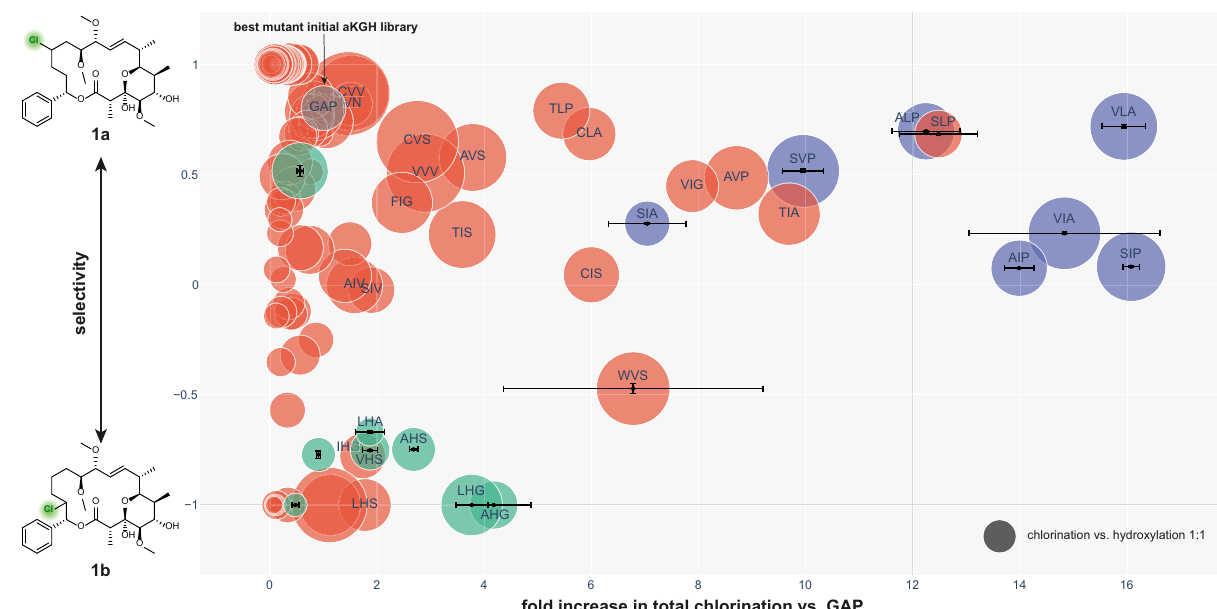
Fig. 3 Biotransformation results of the combinatorial library of WelO5* (red) and the predicted variants (blue and green). Two chlorinated products ( 1a , 1b ) of soraphen A were detected. The y-axis shows the regioselectivity of the chlorination. The selectivity (S) is calculated using the formula S = (SIM 1a – SIM 1b )/(SIM 1a + SIM 1b ). For variants showing a higher than 1.5-fold increase in total chlorination compared to WelO5* V81G/A88A/I161P (GAP, gray) the amino acid sequence of the three engineered positions is shown. On each measured 96-well plate, the variant GAP and negative controls were included as internal references. The combinatorial library variants were measured once. Predicted variants (selectivity; activity) and best-performing variants (SLP; WVS) were measured in triplicate as individual experiments. Data were presented as mean values± standard deviation. The size of the circle corresponds to higher chlorination vs hydroxylation activity. As a reference, the dark gray sphere corresponds to a 1:1 halogenation to hydroxylation activity (area halogenation products/area hydroxylation products).